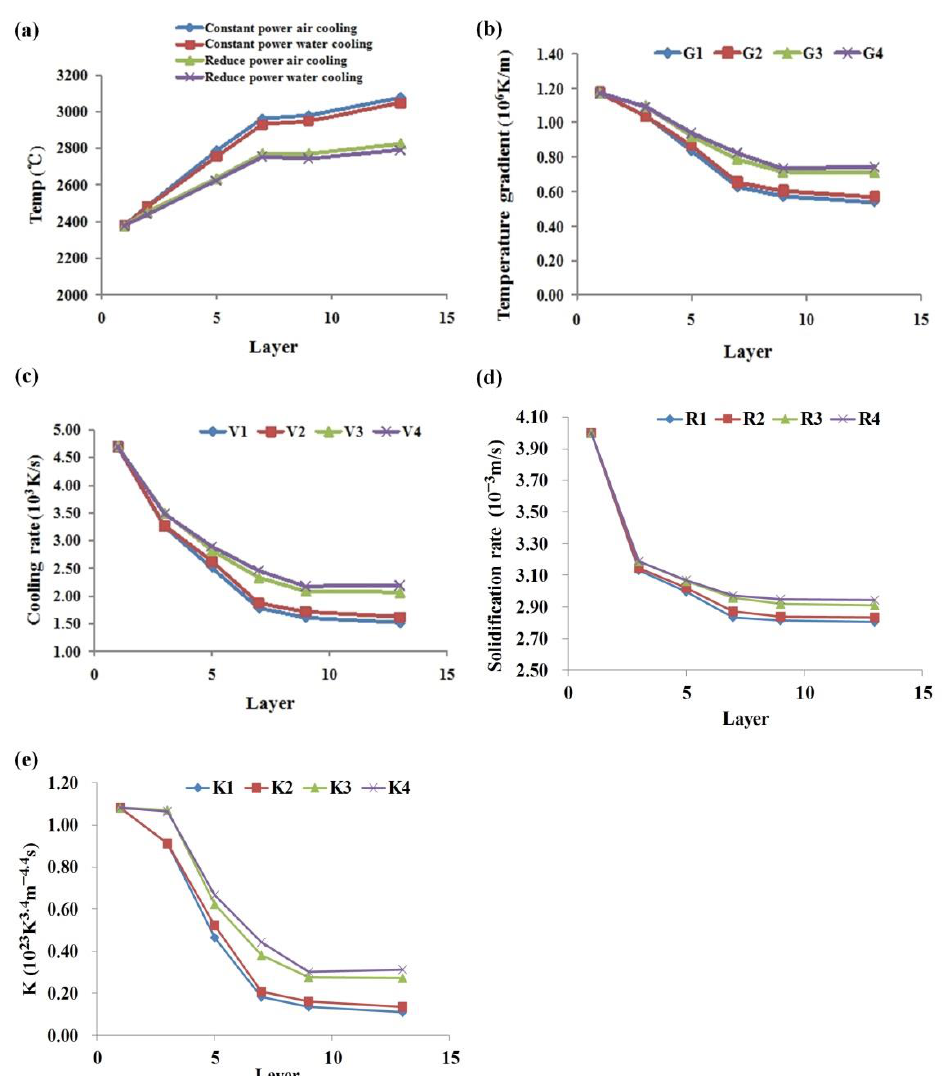
Figure 13. ( a ) Temperature, ( b ) temperature gradient G , ( c ) cooling rate V , ( d ) solidification rate R , ( e ) K value variation with cladding layer, 1 — constant power air cooling, 2 — constant power water cooling, 3 — reduce power air cooling, 4 — reduce power water cooling.